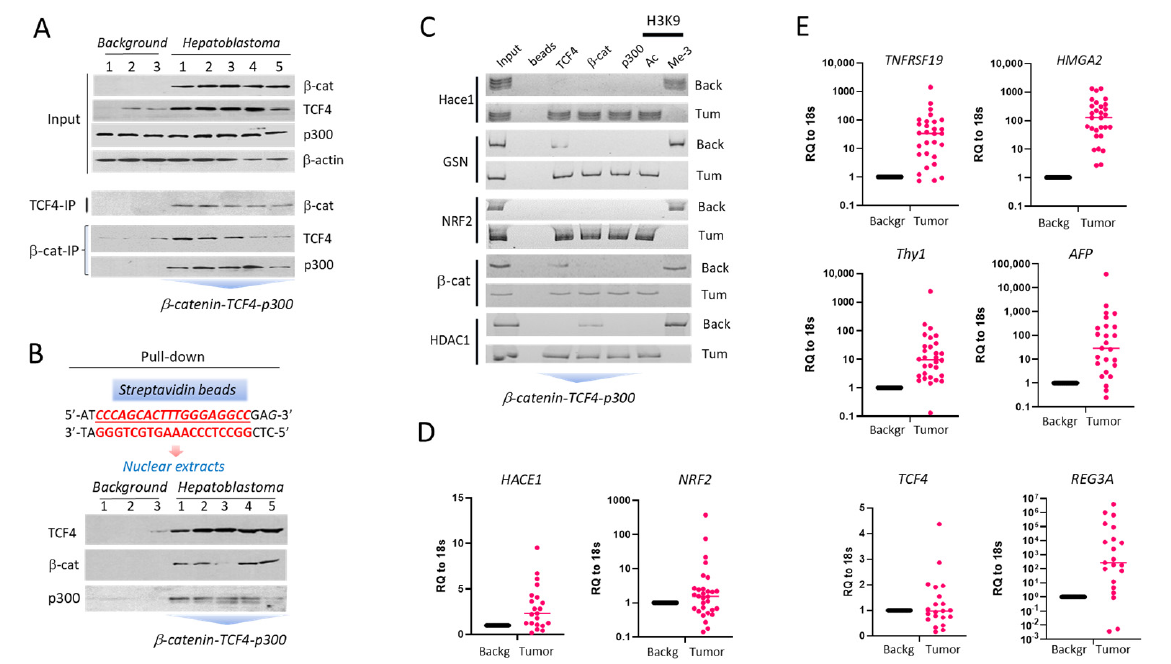
Figure 2. The β -catenin-TCF4 pathway is activated in patients with HBL and increases expression of CEGRs/ALCDs-containing genes. ( A ) Co-IP studies. Input: levels of β -catenin, TCF4, p300 in protein extracts used for IP. Bottom images show results of Co-IP studies. ( B ) Pull-down assay with a DNA oligomer containing a conserved TCF4 binding site identified in all studied CEGRs/ALCDs. ( C ) ChIP assay with CEGRs/ALCDs of five oncogenes. B: beads, in: input. Chromatin solutions from two HBL patients expressing only WT β -catenin were used. ( D , E ) QRT-PCR analyses shows mRNA levels of HACE1 ( p = 0.0006), NRF2 ( p = 0.1985), TNFRSF19 ( p = 0.0407), HMGA2 ( p = 0.0002), Thy1 ( p = 0.2022), AFP ( p = 0.2586), TCF4 ( p = 0.2649), and REG3A ( p = 0.1503) (unpaired t -tests). The